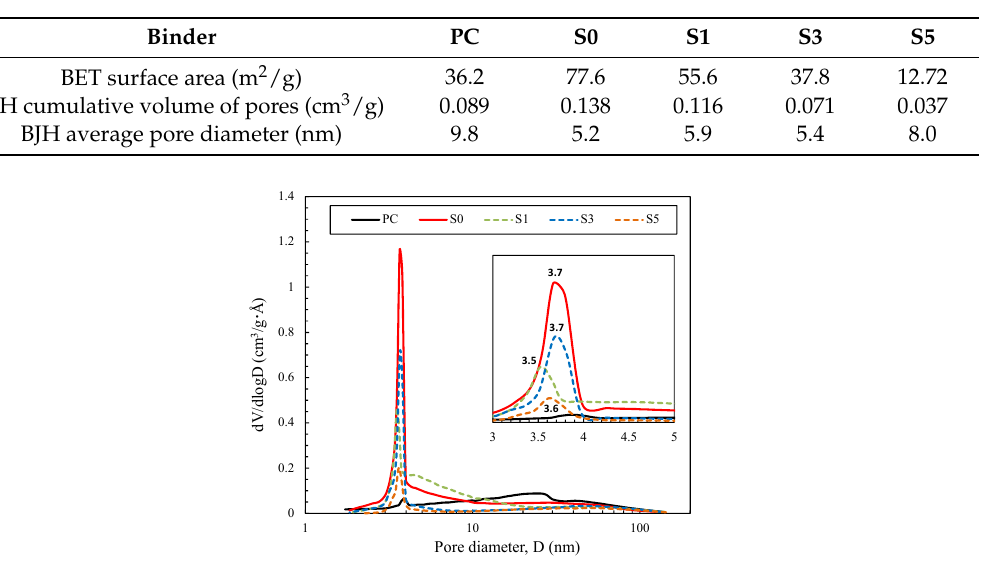
Figure 6. Pore size distribution of powdered binders measured by a BJH N 2 desorption method.